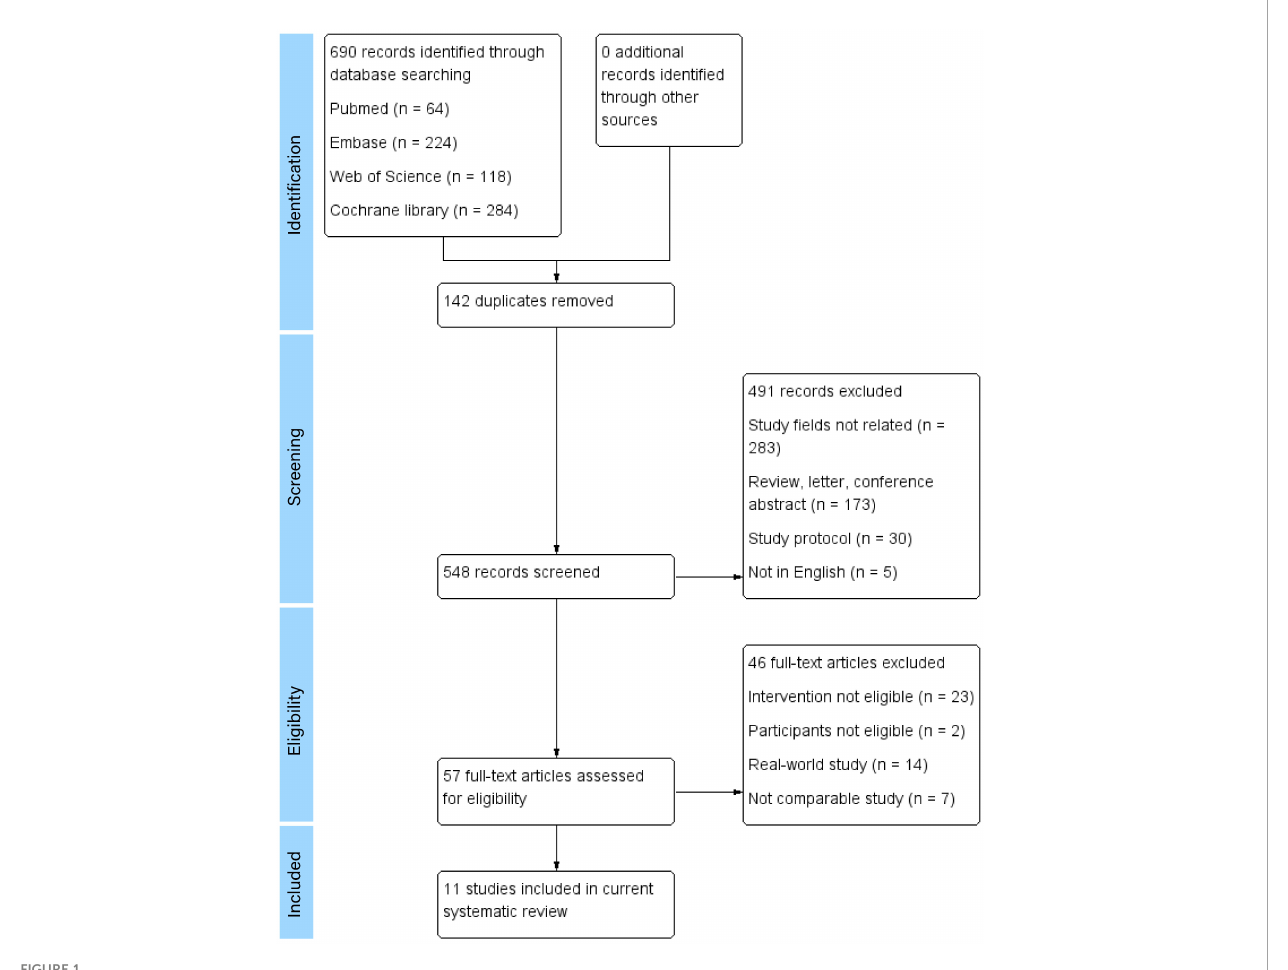
FIGURE 1 Study selection process and the reasons for